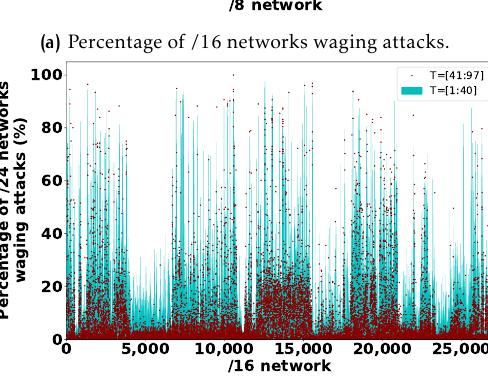
(b) Percentage of /24 networks waging attacks. Figure 4. Plots of the percentage of attacking networks at higher vs. lower network resolution during t ∈ [1 , 40] vs. t ∈ [41 , 97] . Figure 4b plots the percentage of attacking /24 networks with respect to the /16 networks to which they belong, with time t ∈ [1 , 40] vs. t ∈ [41 , 97]. We make two observations. First, among the 27 , 009 /16 attacking networks during t ∈ [1 , 40], 24 , 948 (or 92 . 37%) networks have no more than 25% of their belonging /24 networks waging attacks; 450 (or 1 . 67%) networks have more than 50% of their belonging /24 networks waging attacks; 112 (or 0 . 41%) networks have more than 75% of their belonging /24 networks waging attacks. On the other hand, there are also 27 , 009